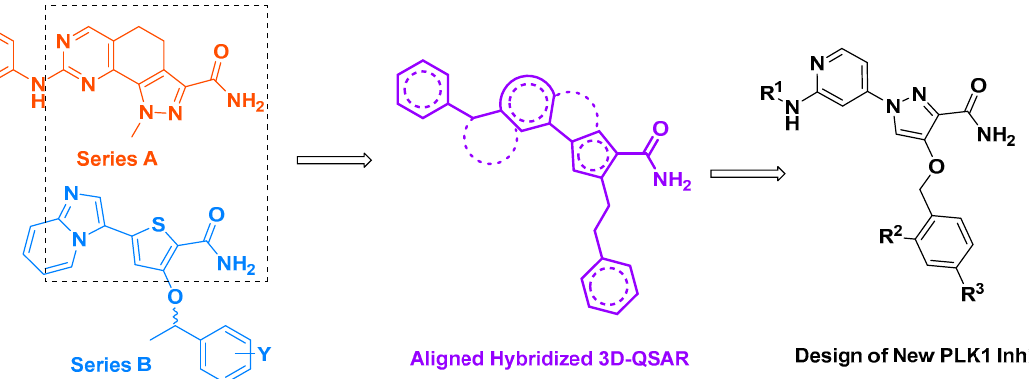
Figure 4. Design of a novel PLK1 inhibitor by the hybridization of two QSAR models. The general synthesis of the designed 4-((2-R 2 -4-R 3 -benzyl)oxy)-1-(2-(2-R 1 - aminopyridin-4-yl)-1 H -pyrazole-3-carboxamide ( 8a – 10a , 13a – b , 14a – b , 15 – 18 ) is shown in Scheme 1. For synthesis of the 1, 3, 4-substituted pyrazole core, we azo coupled diazotized 2-fluoropyridin-4-amine ( 1 ) and ethyl 4-chloro-3-oxobutanoate and obtained ethyl (E)-4- chloro-2-(2-(2-fluoropyridin-4-yl)hydrazinylidene)-3-oxobutanoate ( 2 ) as an